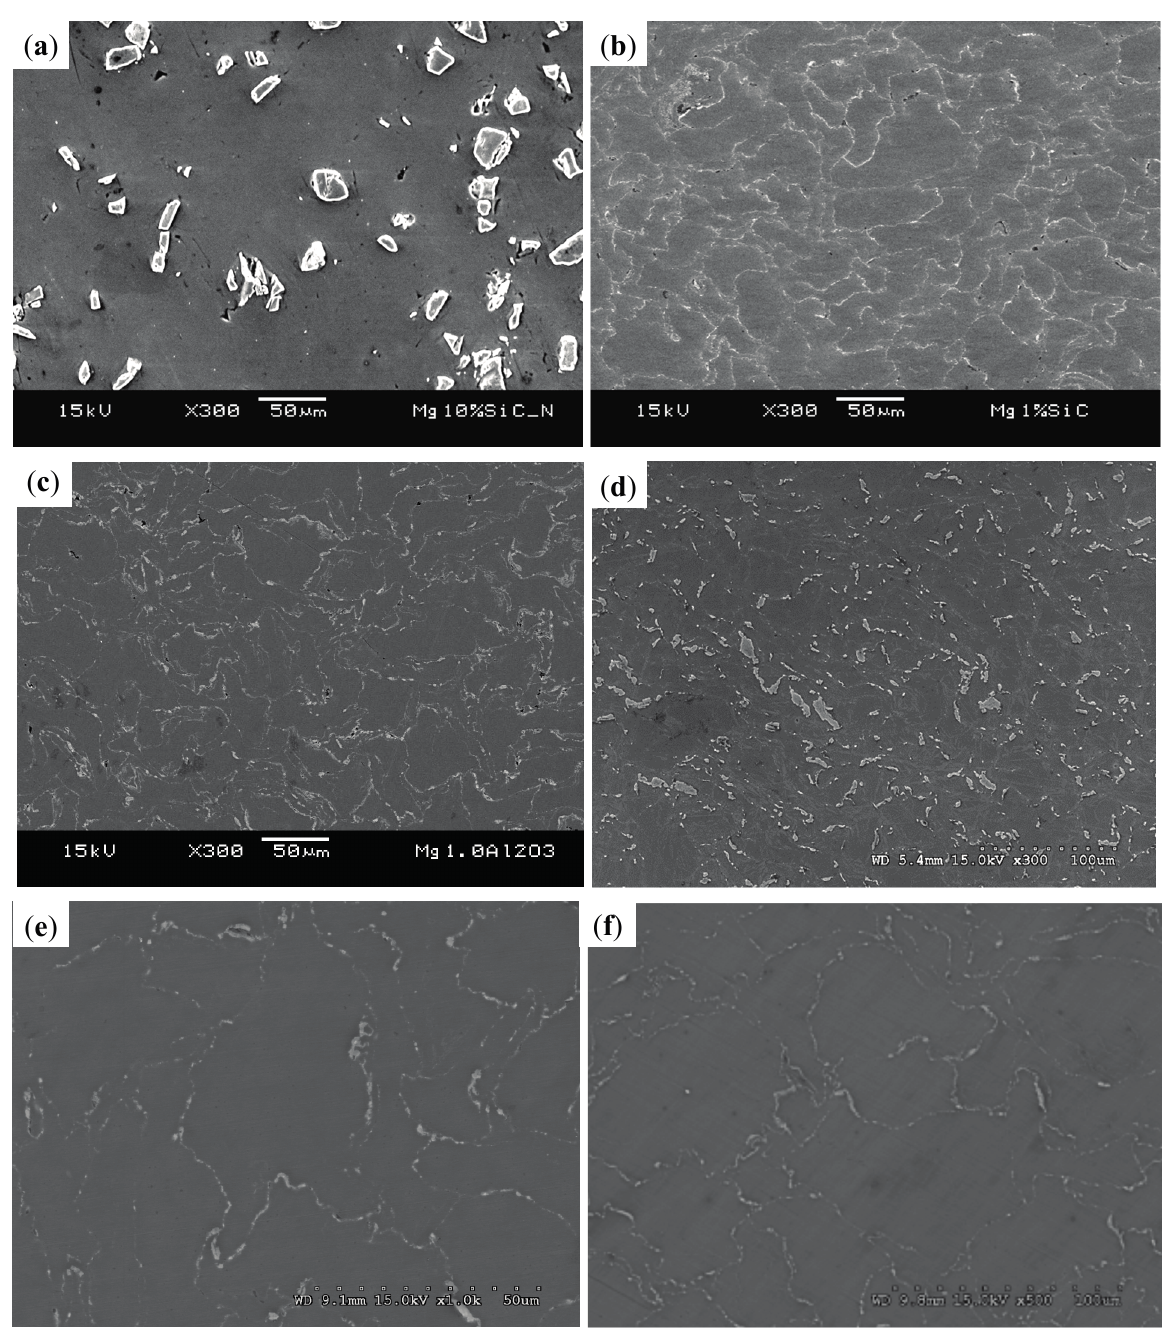
Figure 7. Representative SEM micrographs showing the distribution of reinforcements for ( a ) Mg 10 SiC; ( b ) Mg 1.0 β -SiC [20]; ( c ) Mg 1.0 Al 2 O 3 ; ( d ) Mg 1.0 Cu; ( e ) Mg 0.7 Y 2 O 3 [18]; and ( f ) Mg 1.0 ZrO 2